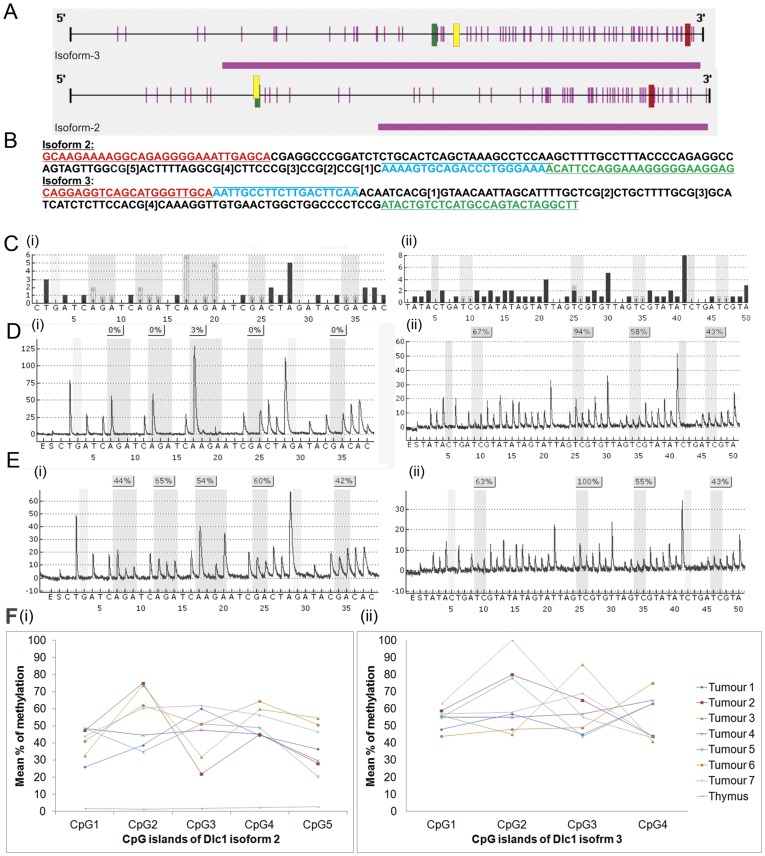
Methylation analysis of the CpG islands in Dlc1 promoter.(A) Diagrammatic representation of the CpG islands (pink horizontal bar), Sp1 promoter binding site (yellow vertical bar), translation start codon (red vertical bar close to 3′end), and the CpG islands selected for methylation analysis (dark green vertical bar) in the promoter region of Dlc1 isoforms 2 and 3. (B) DNA sequence and location of the sequencing primers for pyrosequencing (underlined red and green - forward and reverse PCR primer respectively, italics-sequencing primer). (C) Dispensation order and reference pyrogram of isoforms 2(i) and (ii). Pyrogram of the normal (D) and tumour tissue (E) for isoforms 2 (i) and 3(ii). F: Plot showing the mean percentage of methylation in the different CpG sites on the Dlc1 isoforms 2 and 3 promoters in tumours and normal thymus.